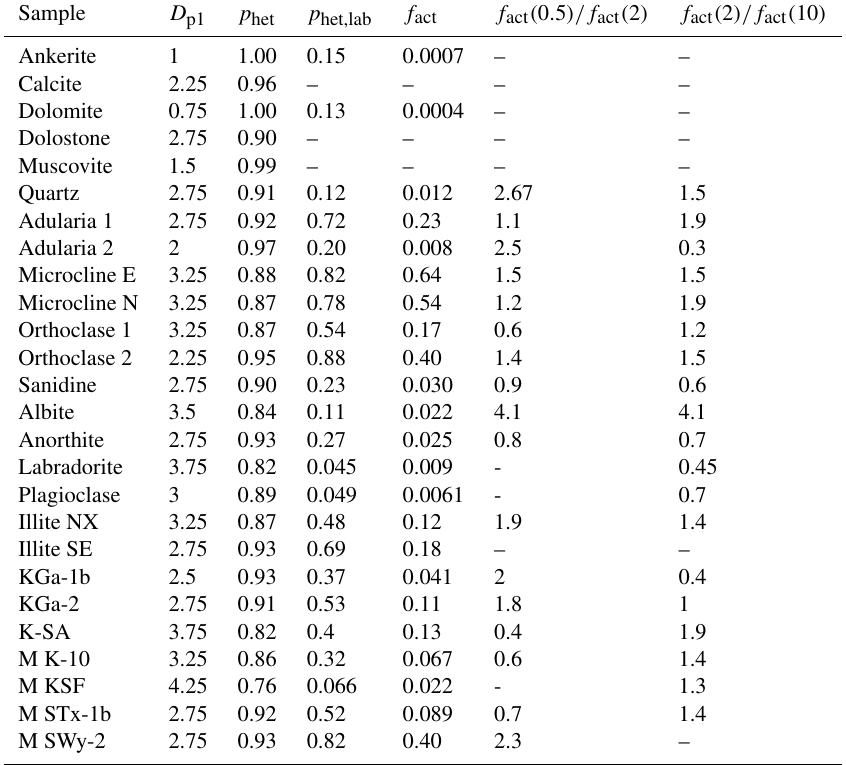
Table 5. Evaluation of active particle fractions ( f act ) of natural dust samples applied to 2wt% suspensions, with the exceptions of ankerite (50wt%), dolomite (50wt%), and muscovite (10wt%). D p1 : droplet diameter with on average 1 particle inside (µm); p het : calculated heterogeneously frozen droplet volume fraction assuming that droplets containing particles froze heterogeneously; p het,lab : measured het- erogeneously frozen water volume fraction; f act ( 0 . 5 )/f act ( 2 ) : ratio of f act determined for 0.5 and 2wt% suspensions; f act ( 2 )/f act ( 10 ) : ratio of f act determined for 2 and 10wt%